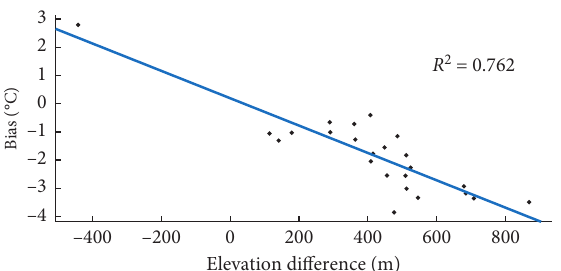
Figure 4: Relationship of bias and elevation differences between daily observations and ERA-Interim during the 1979–2017 period. –4–2024 R 2 = 0.837